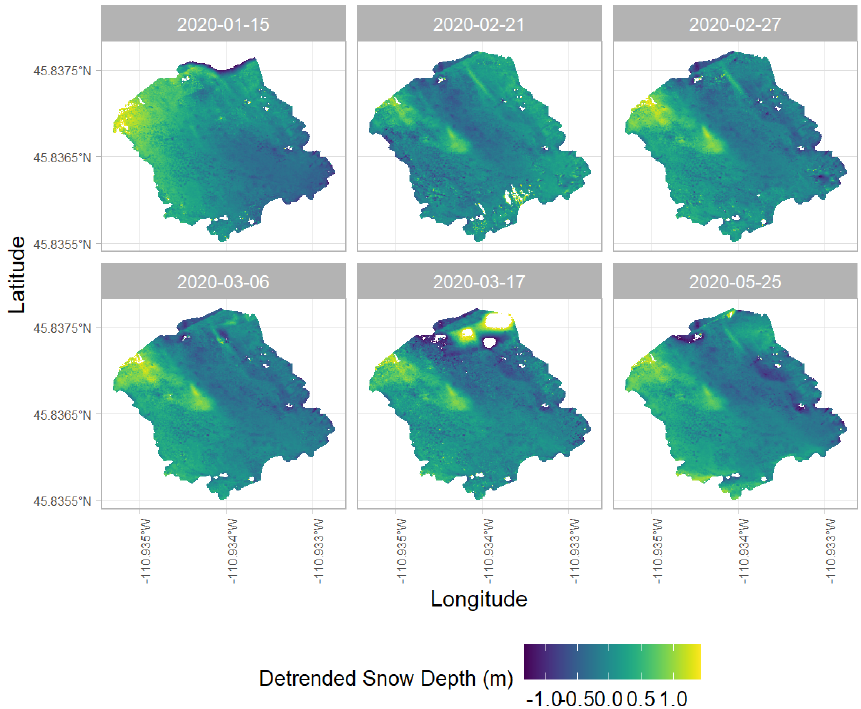
Figure A8. Time series of detrended snow depth maps of the meadow study